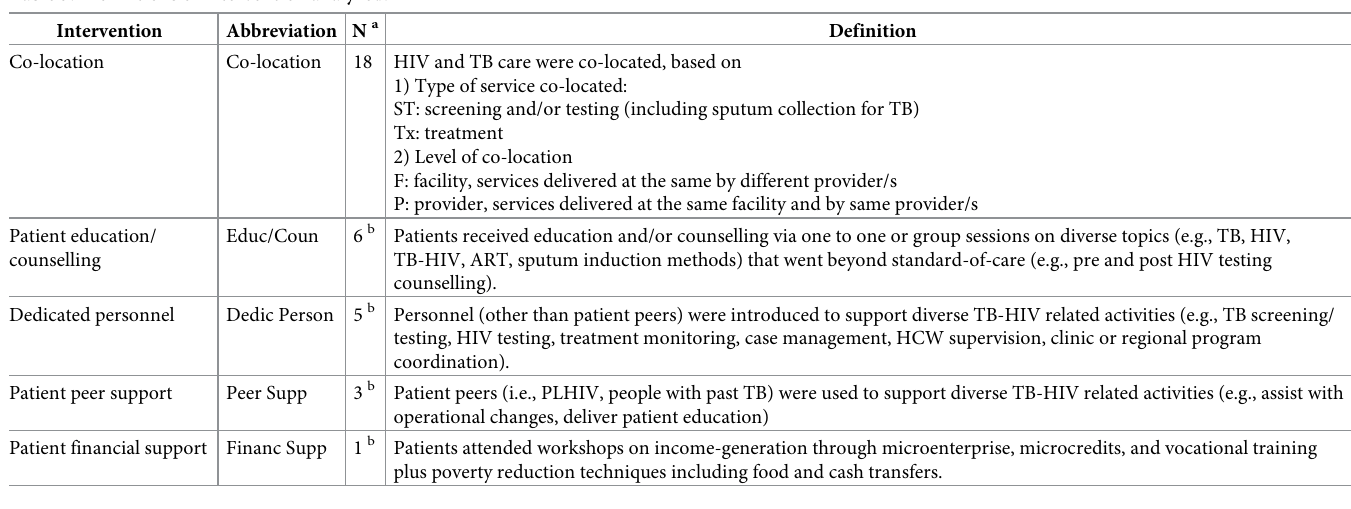
Table 3. Definitions of intervention analyzed.